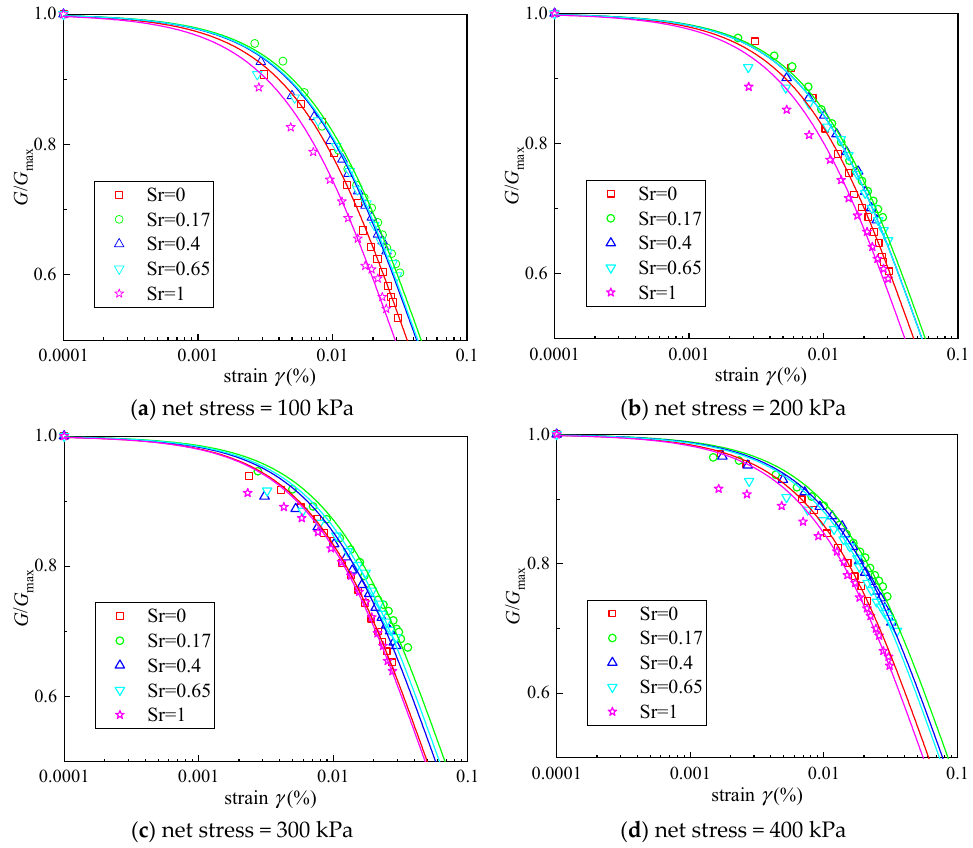
Figure 9. Relationship between G/G max and shear strain at different net stress ( a ) 100 kPa; ( b ) 200 kPa; ( c ) 300 kPa; ( d ) 400 kPa.